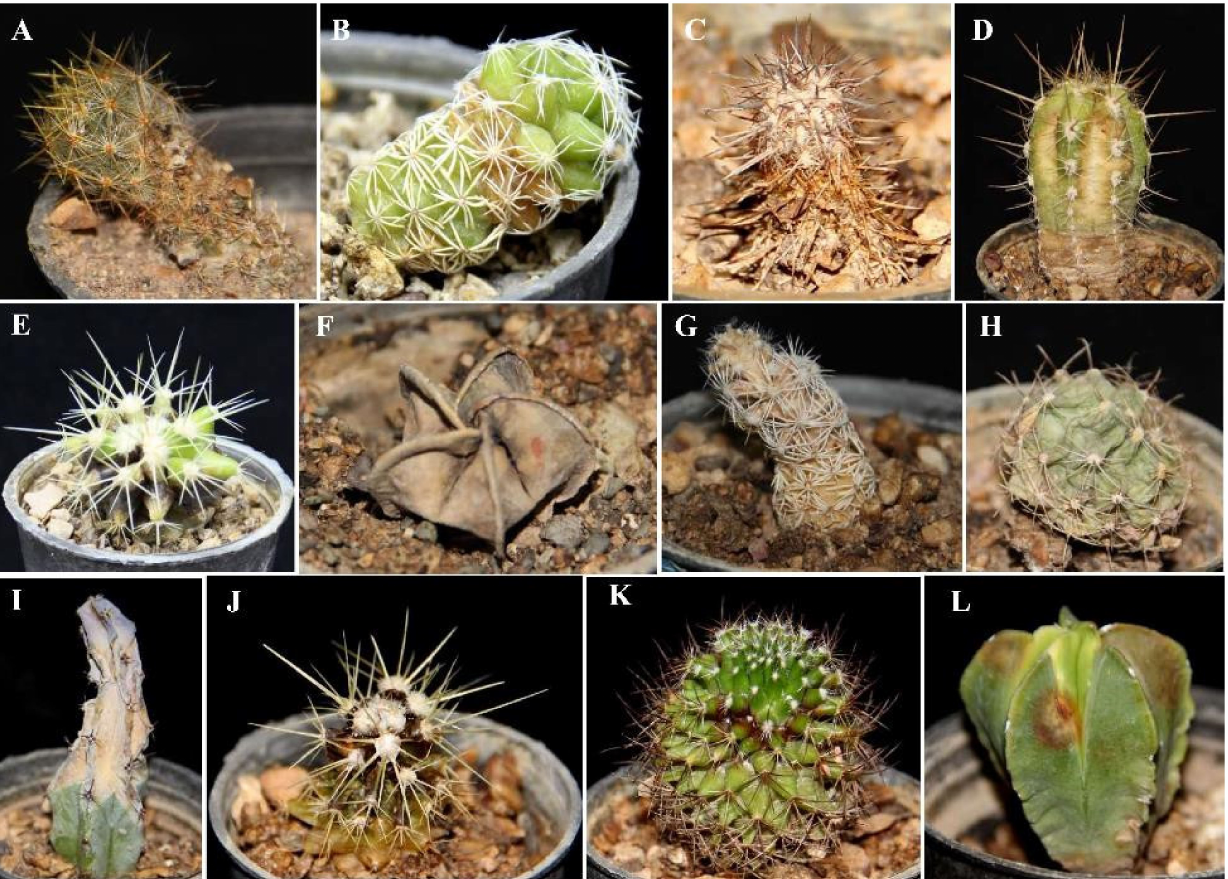
Figure 6. Symptoms induced by artificial inoculation of Fusarium proliferatum on different succulent plants. ( A ) rotting, yellowing, and girdling of the basal stem in Mammillaria prolifera ; ( B ) root and crown rot on Mammillaria gracilis ; ( C ) plant decline and death on Mammillaria pottsii ; ( D ) crown rot and yellowing on Cephalocereus euphorbioides ; ( E ) black spots on crown and stem of Echinocactus gru- sonii ; ( F ) crown rot and yellowing on Astrophytum myriostigma ; ( G ) crown rot and yellowing on Mammillaria gracilis ; ( H ) basal sunken lesion and root rot in Hamatocactus setispinus (syn. Thelocactus setispinus ); ( I ) plant decline from the top of the stem on Cereus jamacaru ; ( J ) crown rot and yellowing on Echinocactus grusonii ; ( K )crown rot and yellowing on Mammillaria jaliscana ; and ( L ) chlorosis and soft brown spots on Astrophytum myriostigma